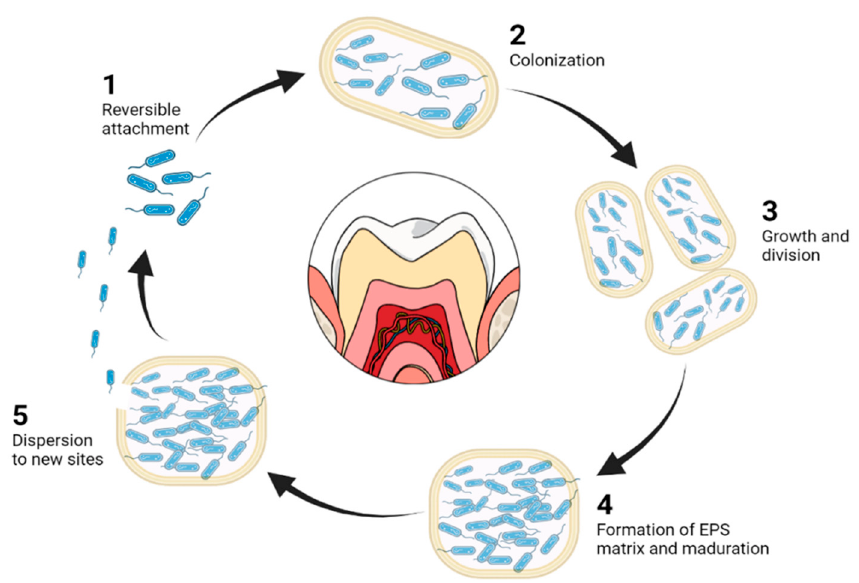
Figure 2. Stages in biofilm formation. (1) Reversible adhesion of bacteria to the infection surface by means of their superficial appendages (pili and flagella). (2) Irreversible adhesion, forming microcolonies. (3) Growth and cell division. (4) Bacterial secretion from the extracellular polymeric matrix, composed of proteins and polysaccharides and biofilm maturation. (5) Bacterial detachment and migration to different environments. Based on